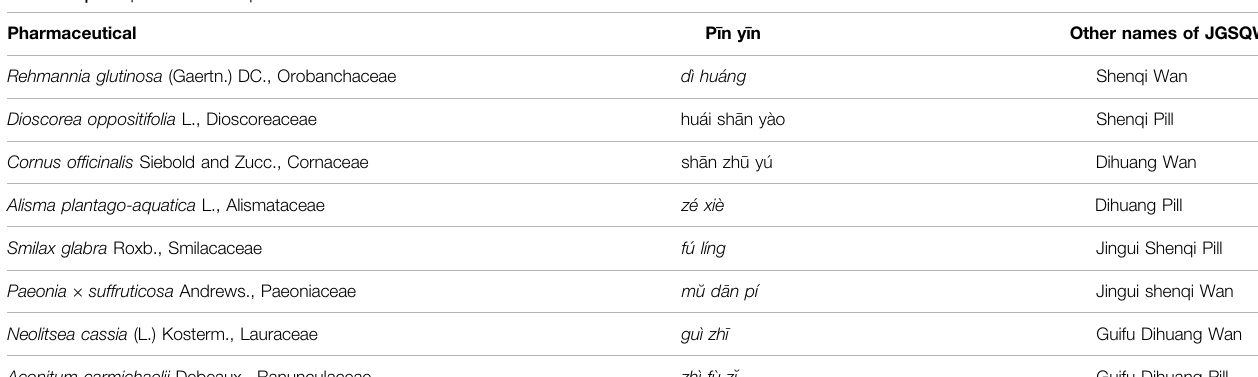
TABLE 1 | Composition and all possible names of